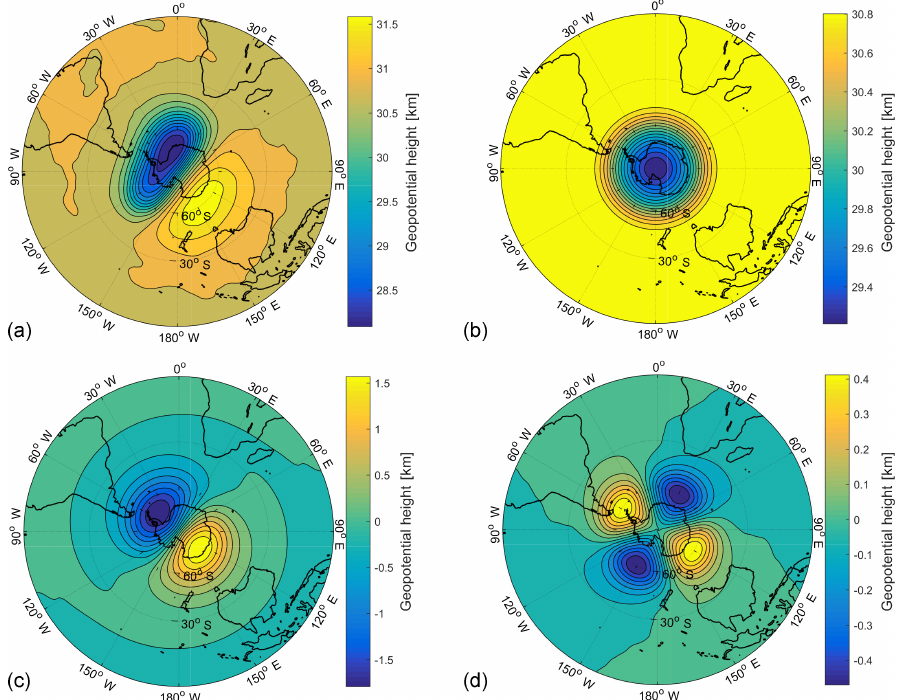
Figure 2. Stereographic projection of the geopotential height field and its Fourier decomposition for the 10hPa pressure level on 22 Septem- ber 2002 at 00:00:00UTC: (a) geopotential height; (b) mean flow; (c) Fourier component Z 1 ; (d) Fourier component Z 2 . Observe how the amplitude of the planetary wave with wave number 1 can be at least 3 times larger than that of wave number